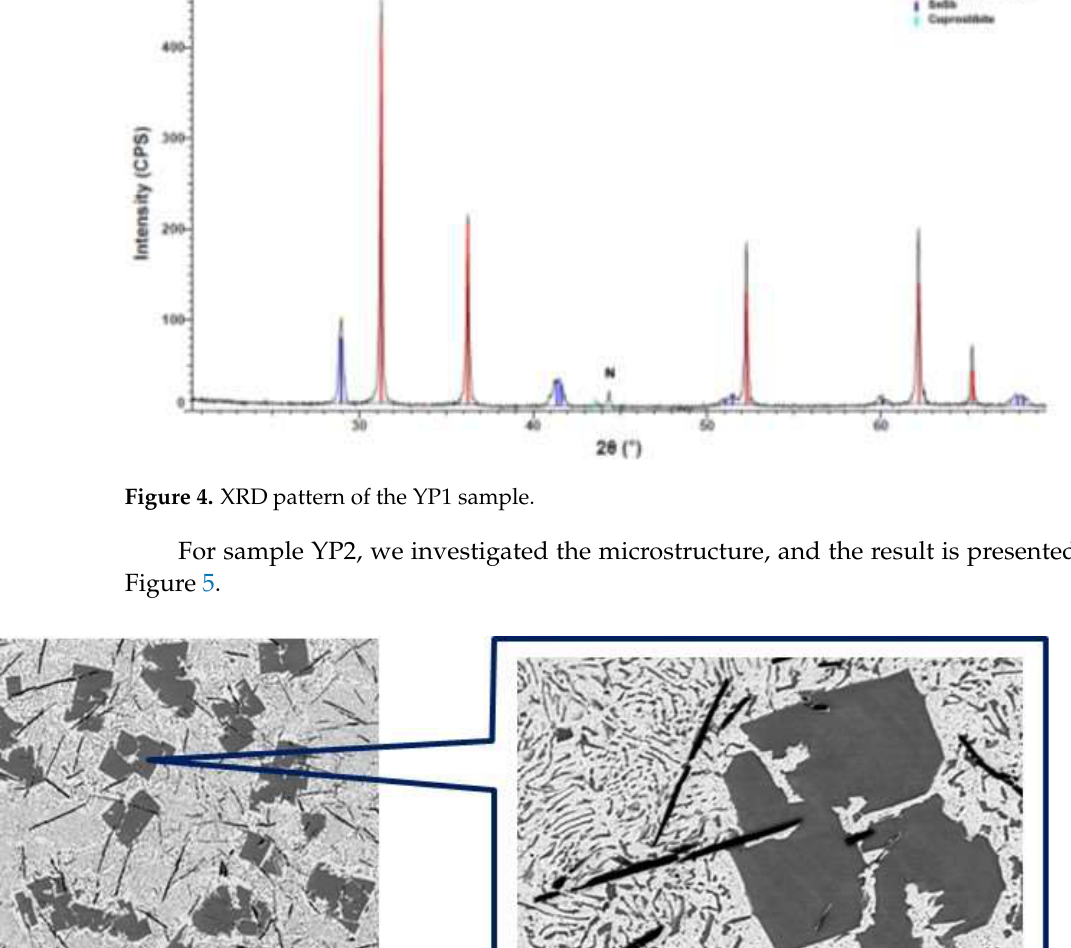
Figure 5. SEM image of YP2 sample at 100 µm and 20 µm.